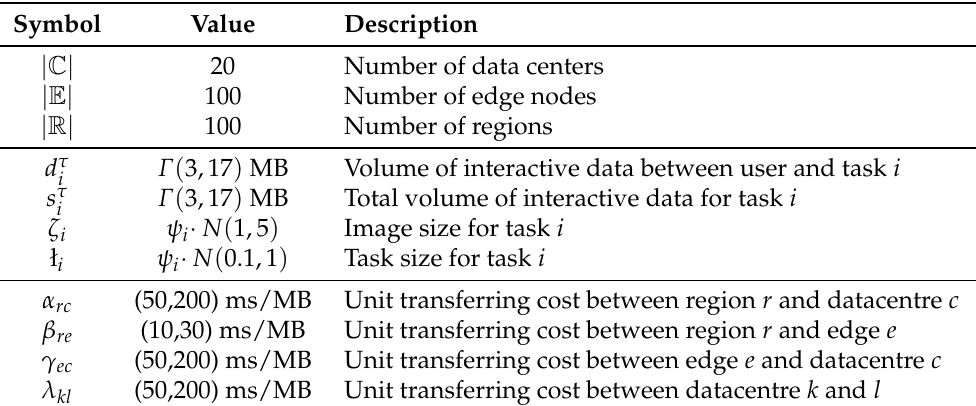
Table 2. Parameter settings for the